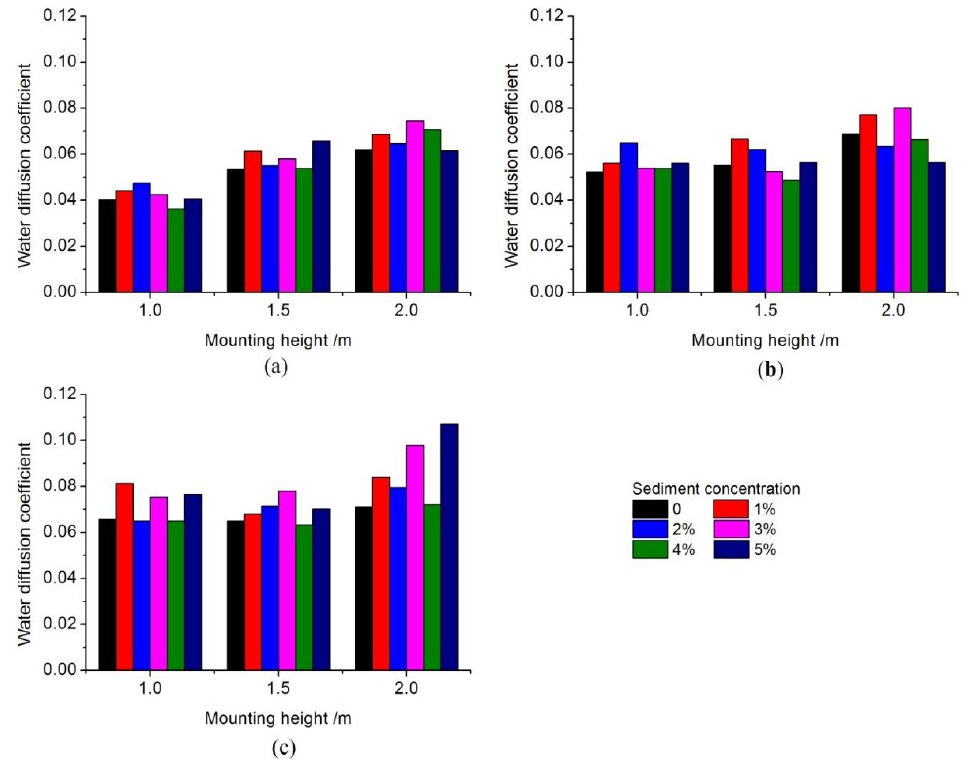
Figure 6. Spray water diffusion coefficient with various sediment contents at different working heights. Note: ( a ) 100kPa, ( b ) 150kPa, ( c ) 200kPa.